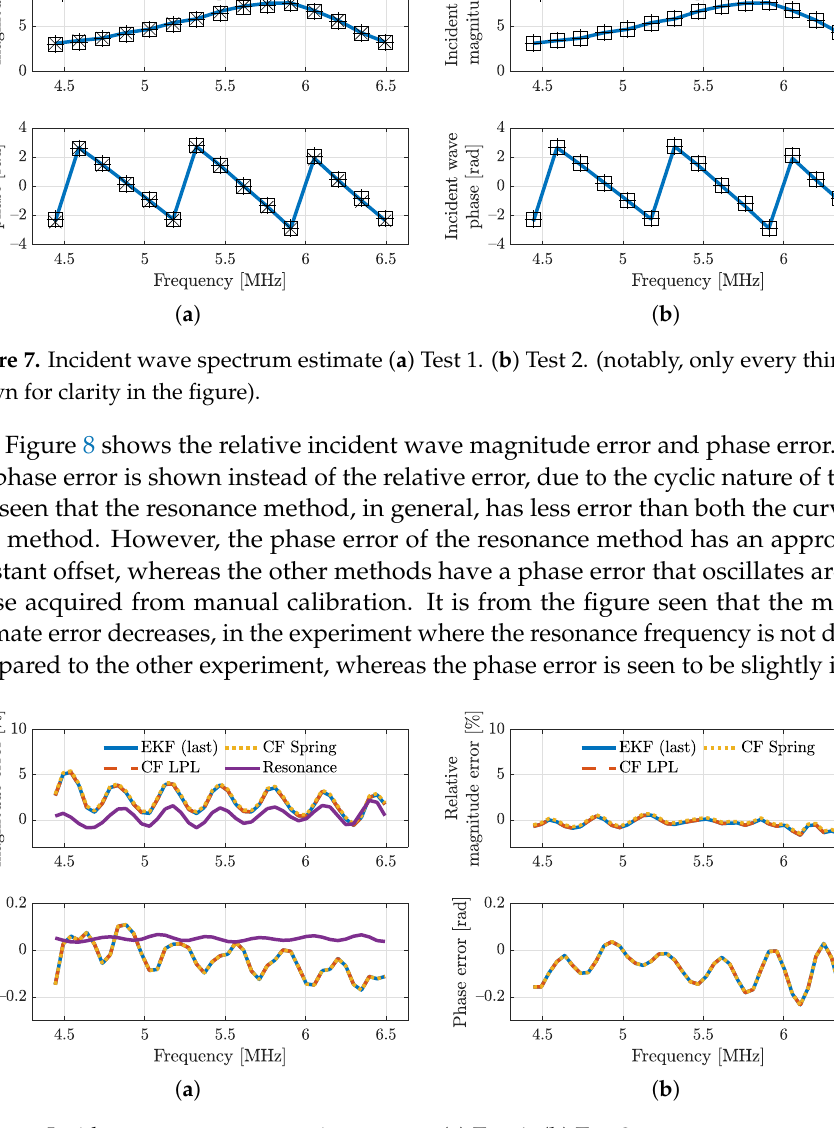
Figure 8. Incident wave spectrum estimate error. ( a ) Test 1. ( b ) Test